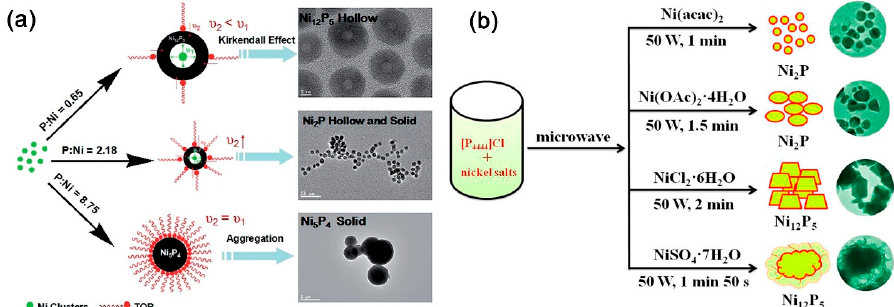
Figure 4. Possible formation mechanism of the as-synthesized nickel phosphide NCs with different phases and morphologies ( a ). Reproduced with permission from Reference [50], Copyright, The Royal Society of Chemistry, 2015. Typical schematic illustration for synthesizing various nickel phosphides controlled by the counter anions of nickel salts ( b ). Reproduced with permission from Reference [56], Copyright, the American Chemical Society, 2018.